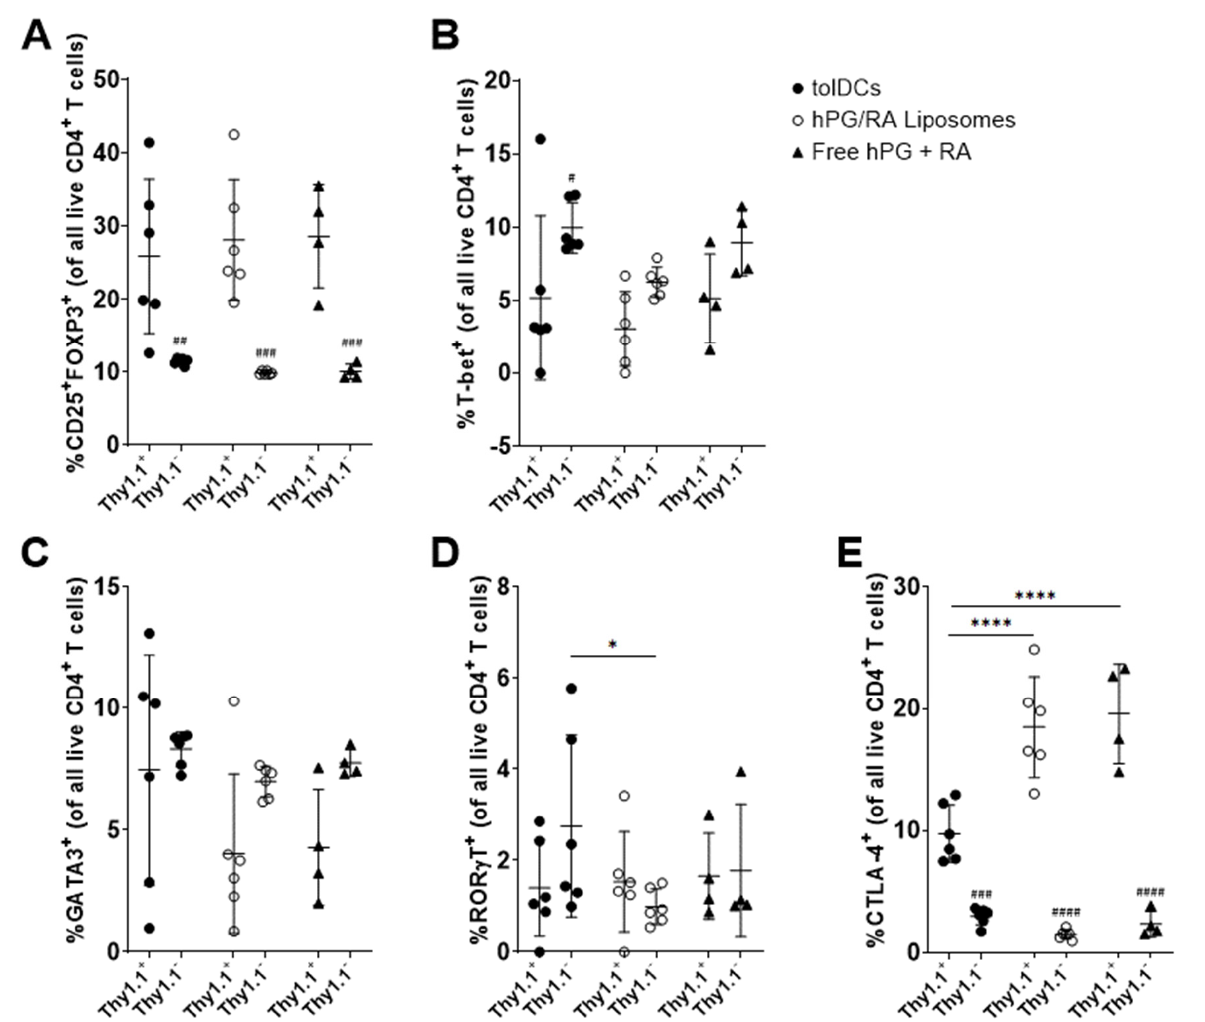
Figure 8. Effect of RA and hPG delivery on the splenic CD4 + T cell subsets in vivo. WT Balb/c mice received CFSE-labeled Thy1.1 + CD4 + CD25 − T cells isolated from the spleens of hPG-TCR transgenic mice via intravenous injection. 24 h after injection, mice received intravenous injections of either tolDCs pulsed with hPG and RA (tolDCs), liposomes encapsulating hPG and RA (hPG/RA Liposomes), or free hPG + RA. Three days after injection, splenic CD4 + T cells were assessed by flow cytometry. ( A ) %CD25 + FOXP3 + ( B ) %T-bet + ( C ) %GATA3 + , ( D ) %ROR γ T + ( E ) and % CTLA-4 + cells within the Thy1.1 + and Thy1.1 − CD4 + T cell populations. n = 6 for tolDCs and hPG/RA Liposomes, n = 4 for free hPG + RA control. Means ± SD, **** p < 0.0001, * p < 0.05. #### p < 0.0001, ### p < 0.001, ## p < 0.01, # p < 0.05 comparing Thy1.1 + to Thy1.1 − . Statistics performed by two-way ANOVA and Bonferroni’s multiple comparisons test.